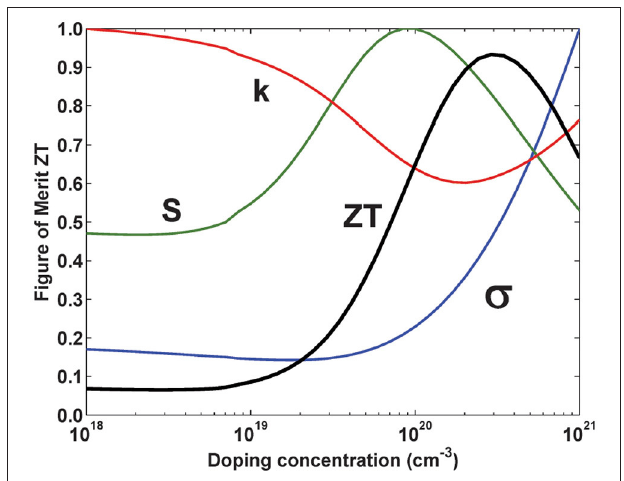
FIGURE 4 | Normalized TE properies and ZT vs. doping concentration at 300K for N-type Si80Ge20 ( Minnich et al., 2009).